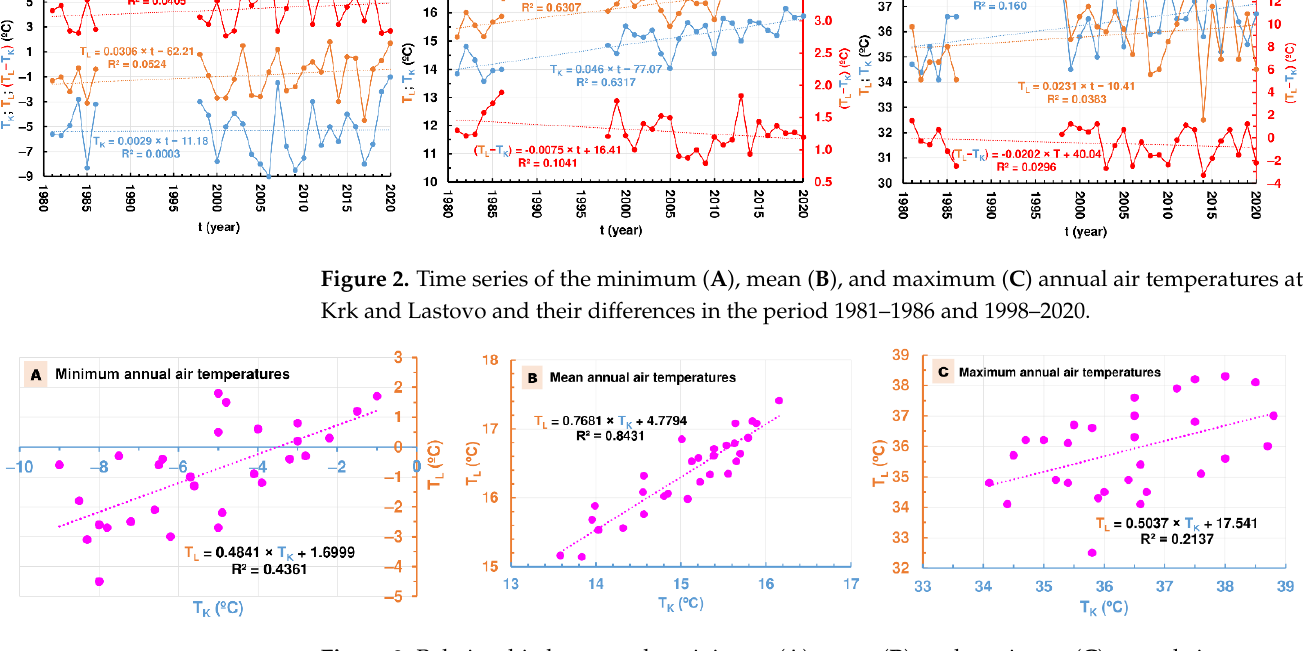
Figure 3. Relationship between the minimum ( A ), mean ( B ), and maximum ( C ) annual air temper- atures at Lastovo (ordinate axis) and Krk (abscissa axis).